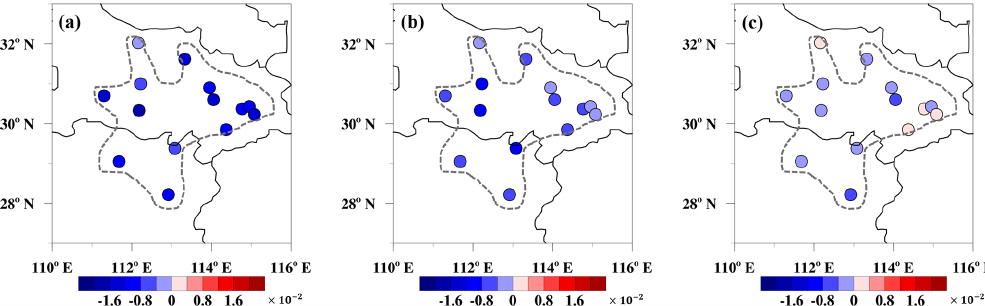
Figure 6. Spatial distributions of the linear trends in emissions-related long-term components of (a) PM 2 . 5 , (b) SO 2 and (c) NO 2 (unit: µgm − 3 d − 1 ) over 2015–2019 in the